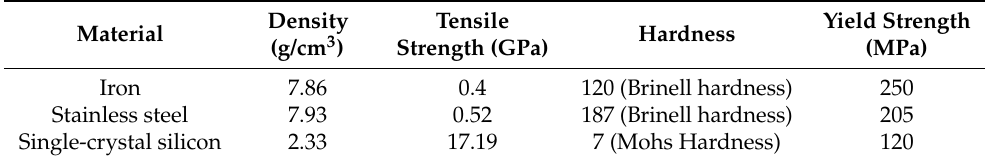
Table 4. Performance of iron, stainless steel and silicon.